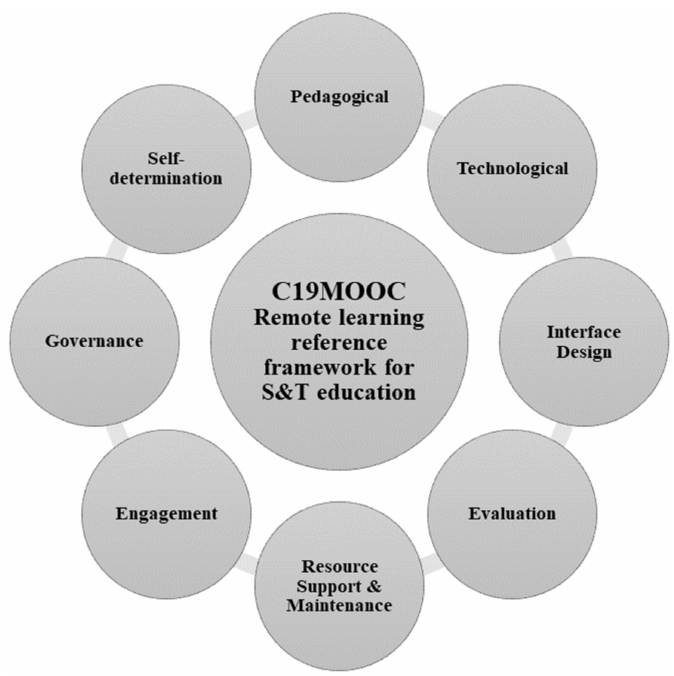
Figure 2. Remote learning reference framework for S&T education